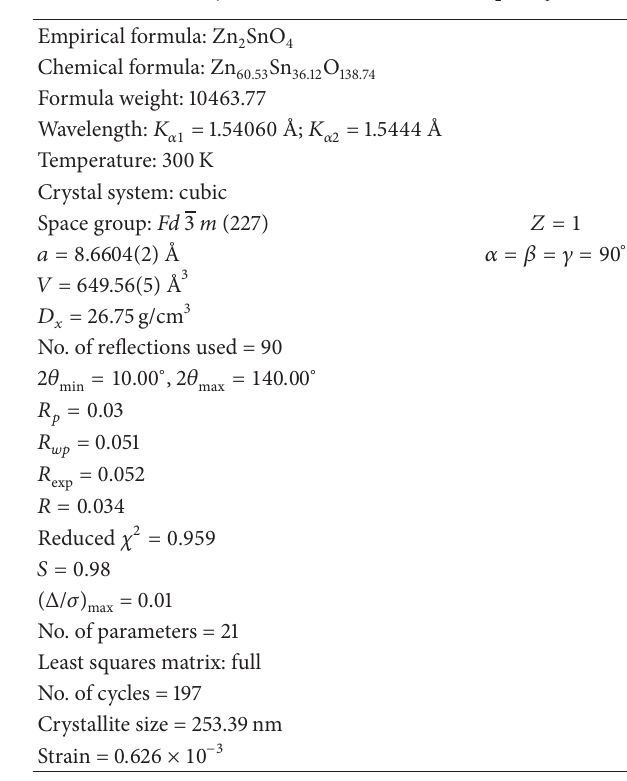
Table 3: Crystal and refinement data of Zn